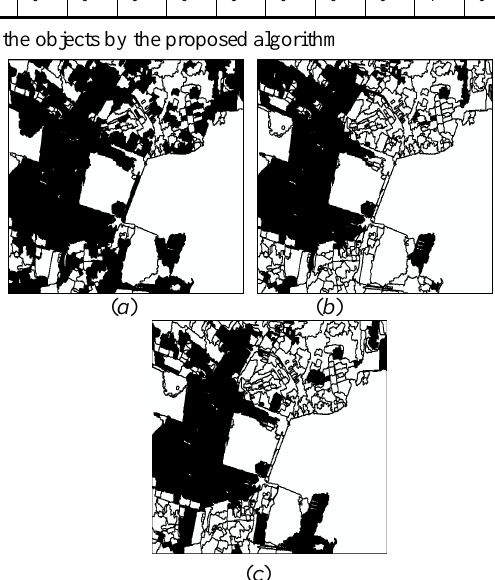
Table 4 .Error matrix of the land-cover transitions of the objects by the proposed algorithm